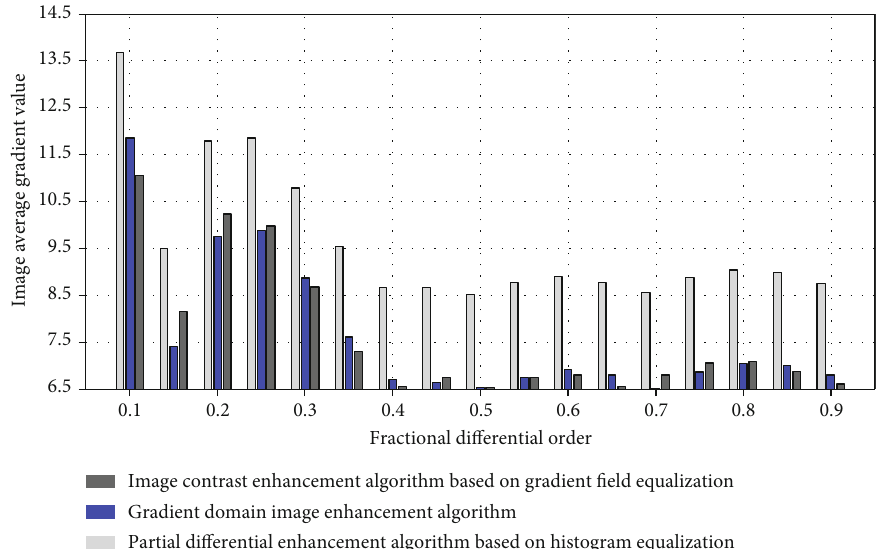
Figure 7: Comparison of average gradient values of images under di ff erent fractional di ff erential